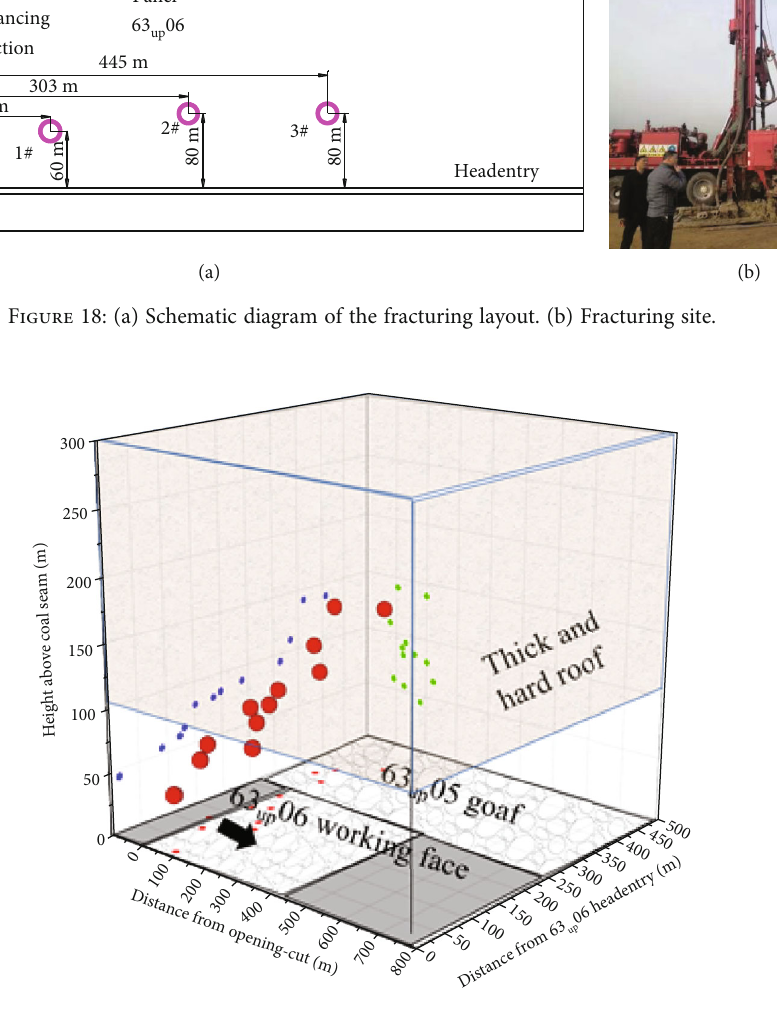
06 working face. up